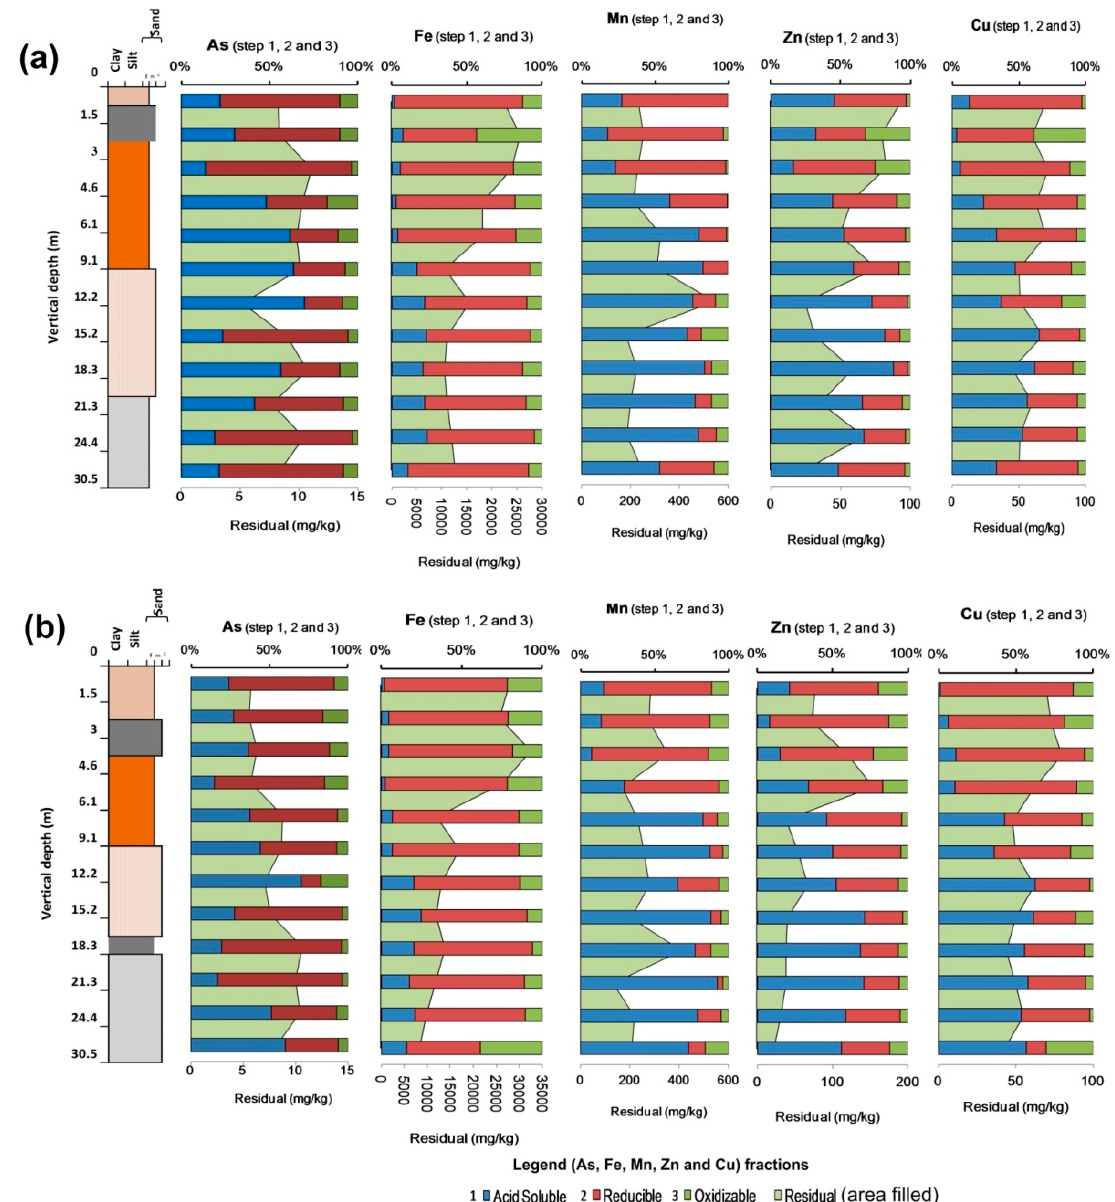
Figure 5. Percentage (leachable) and concentration of residual fractions (mg/kg) of As, Fe, Mn, Zn and Cu in each sequential step of the extraction procedure for sediment core profile of ( a ) Rigni Chhapra ( b ) Chaube Chhapra.